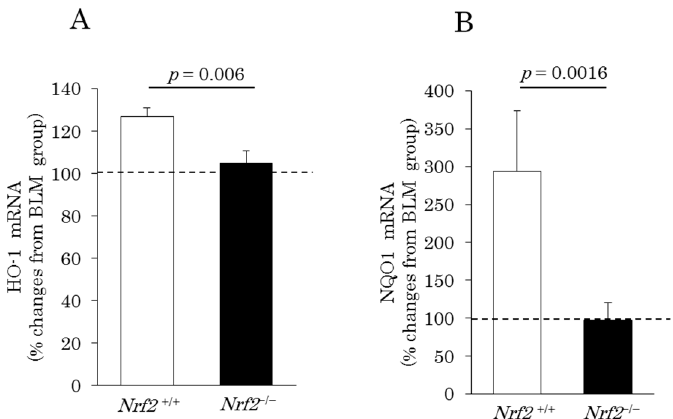
Figure 5. Heme oxygenase (HO)-1 ( A ); and NAD(P)H quinone dehydrogenase (NQO)1 ( B ) mRNA expression levels in the lung tissues on day 10 after BLM injection and after exposure to DE for 38 days. The vertical axis shows percentage changes in the target gene mRNA expression levels of the DE plus BLM group relative to the BLM group. β -actin was used as an internal control. Data are shown as mean ± SD values in each group ( n = 3–5).